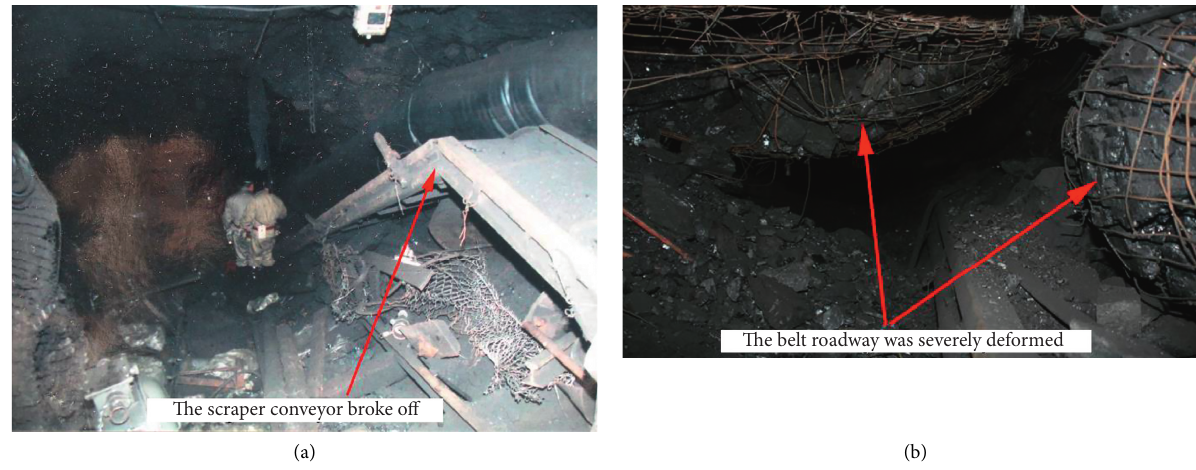
Figure 1: Site photos of rock burst disasters in coal mines. (a) The 3316# air roadway in Sunjiawan coal mine. (b) The 2103# belt roadway in Gucheng coal mine. Note: the two photos in Figure 1 are obtained from the following web page—https://max.book118.com/html/2018/ 1112/7010162164001156.shtm.